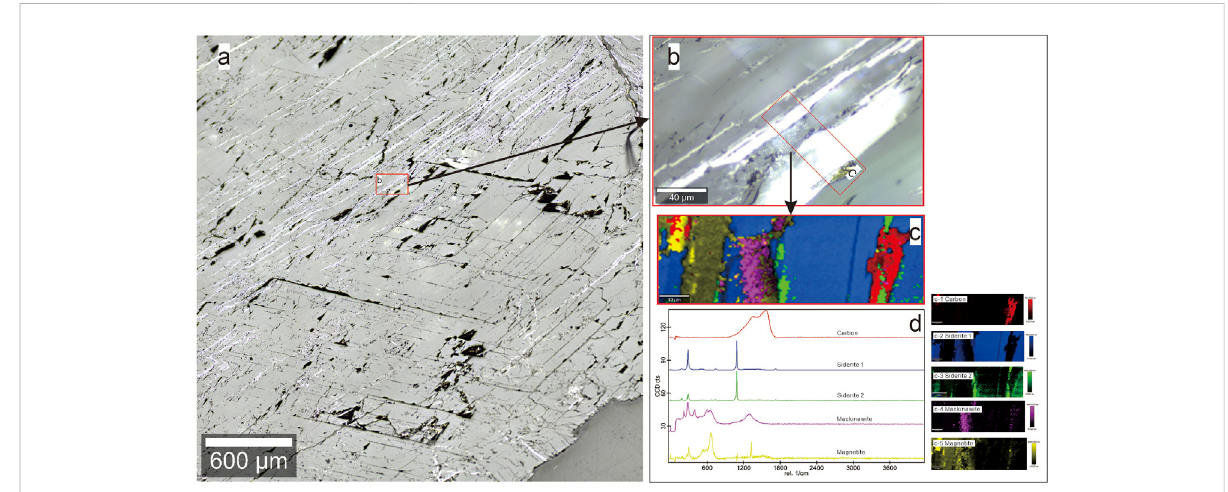
FIGURE 3 A representive Raman analysis results of therecoved siderite sample. (A) The optical microscope imageshowing the presence of microfracture and some new phases in siderite sample after high pressure. (B) The enlarged microscope image of the selected area in (A) and the red enframed region of (C) further analyzed. Combined false-color Raman image in (C) , and the colors correspond to the spectra shown in (D) . Scale bars are shown in each of images. After conductivity measurement, siderite is still the dominant phase with hgih abundances ≥ 88.5%, whereas it underwent low degree decarbonation reaction, generating a very small amount of highly conductive phases (graphite and magnetite). Additionally, mackinawite is probably present in the starting